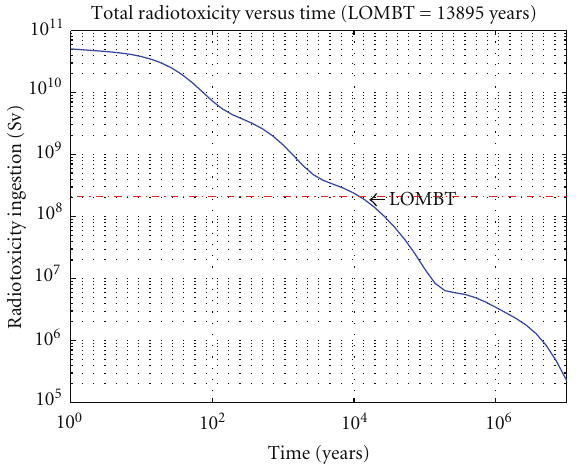
Figure 13: LOMBT of GCFR SNF end second cycle (FPs, Am, and Cm).